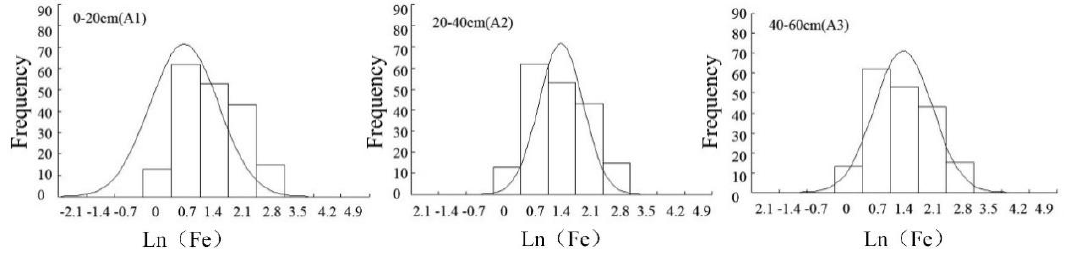
Figure 2. Histograms of soil iron at different soil depths.